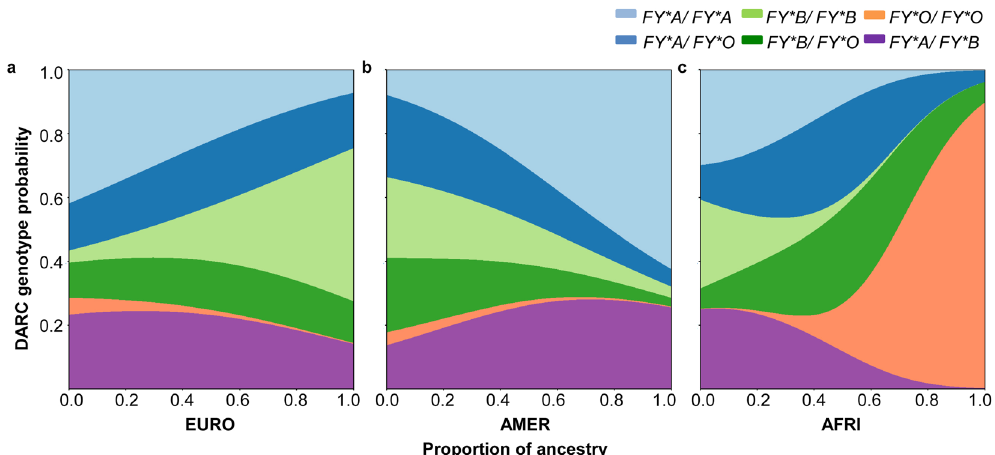
Figure 2. Frequency distribution of DARC genotypes according to the estimated genomic ancestry for the Rio Pardo population. Fitted multinomial logistic regression models showing the association between the distribution of DARC genotypes and ( a ) European, ( b ) Native American and ( c ) African ancestry. The individual proportion of genomic ancestry is shown in the x-axis. The y-axis is labeled on the probability scale and shows the variation in the probability of a genotype along with the variation in ancestry